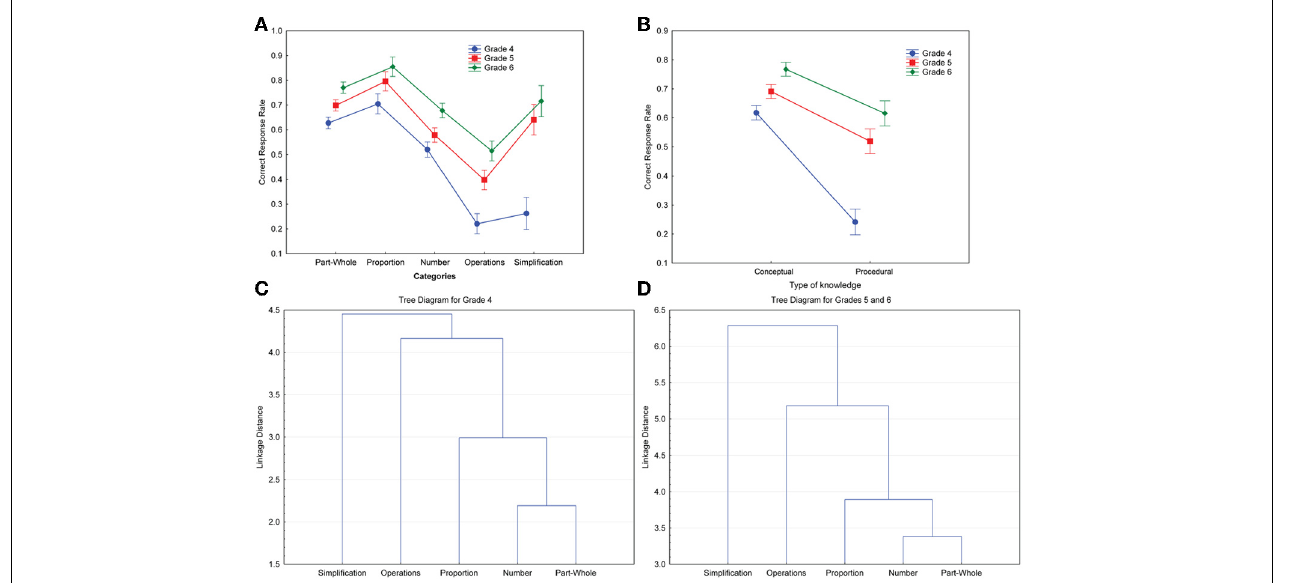
FIGURE 2 | The top two panels show the interaction between grade and correct response rates for each category (A), and between grade and each type of knowledge (B). Vertical bars denote 95% confidence intervals.